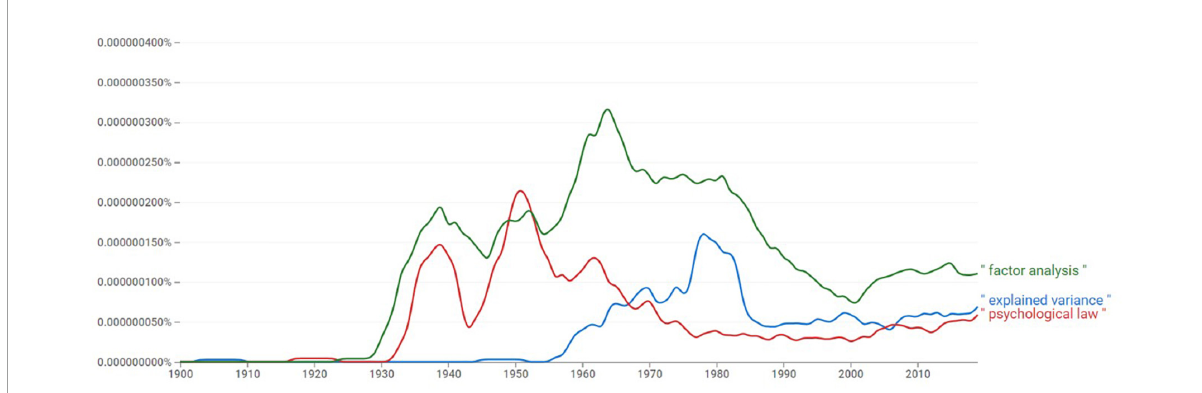
FIGURE5 The relative prevalence of the terms “psychological law,” “factor analysis,” and “explained variance” in the English language throughout the years 1900-2010 (Source: Google nGram viewer).